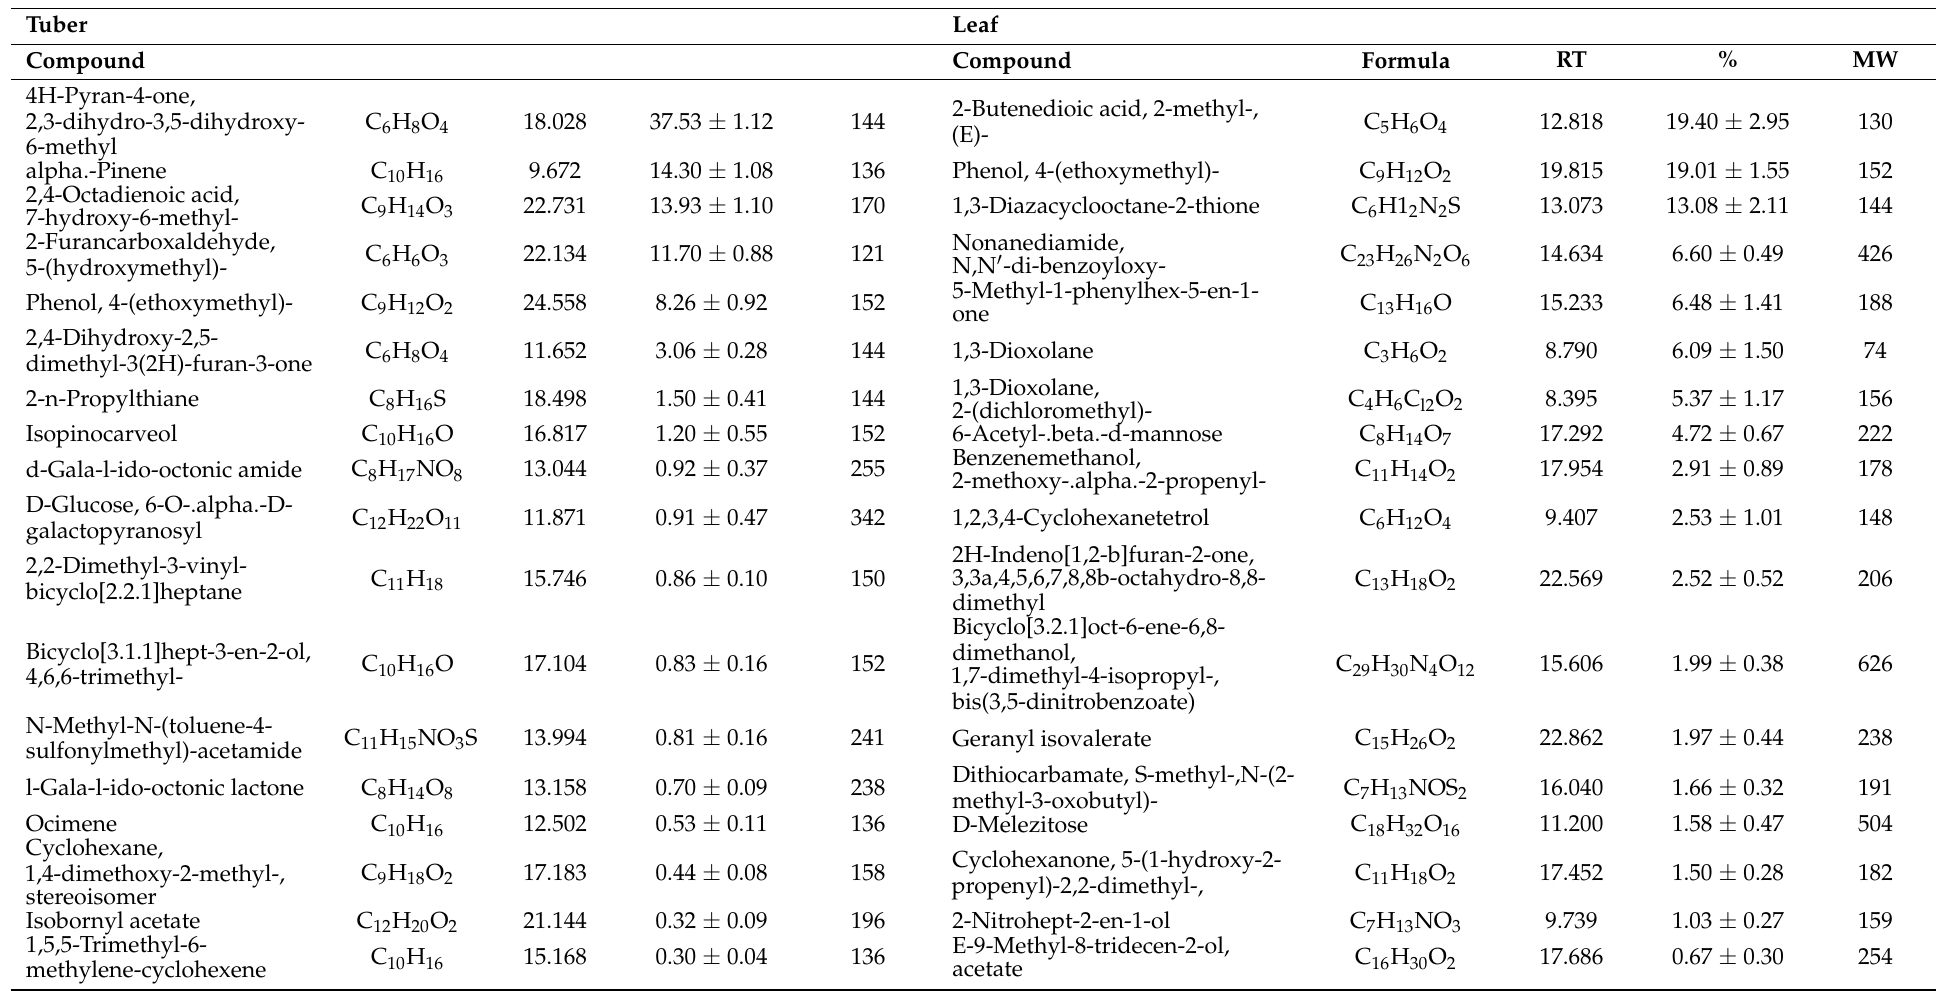
RT, retention time determined on DB-17MS capillary column. Components are listed in order of percentage for each organ. MW, molecular weight. Values represent the means ± standard